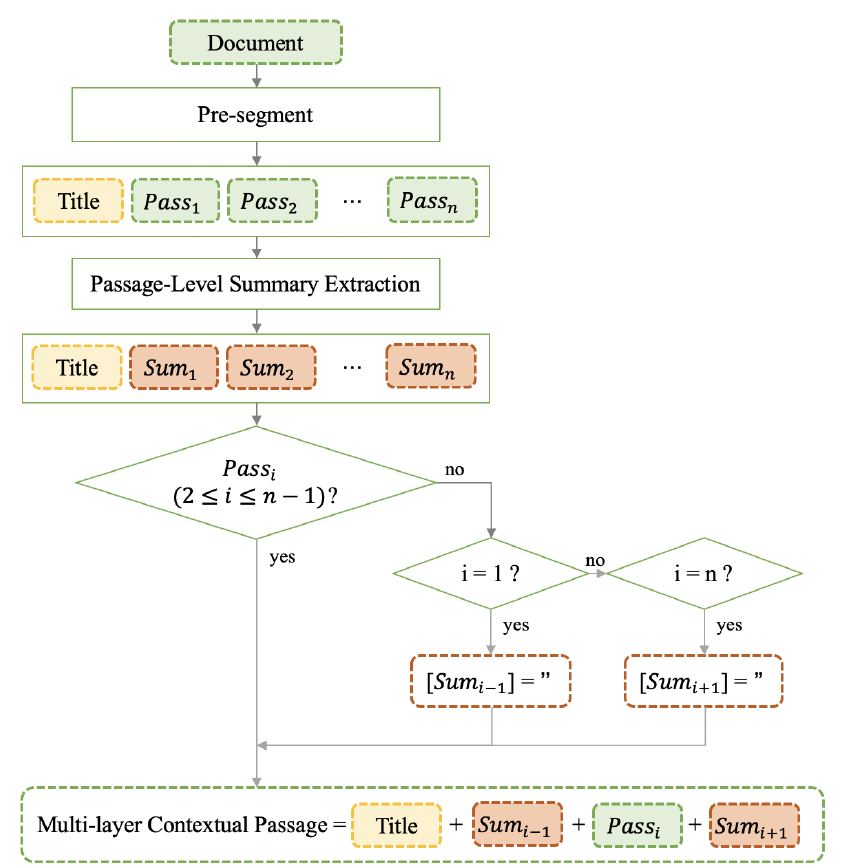
Figure 5. Multi-level context paragraph structure generation